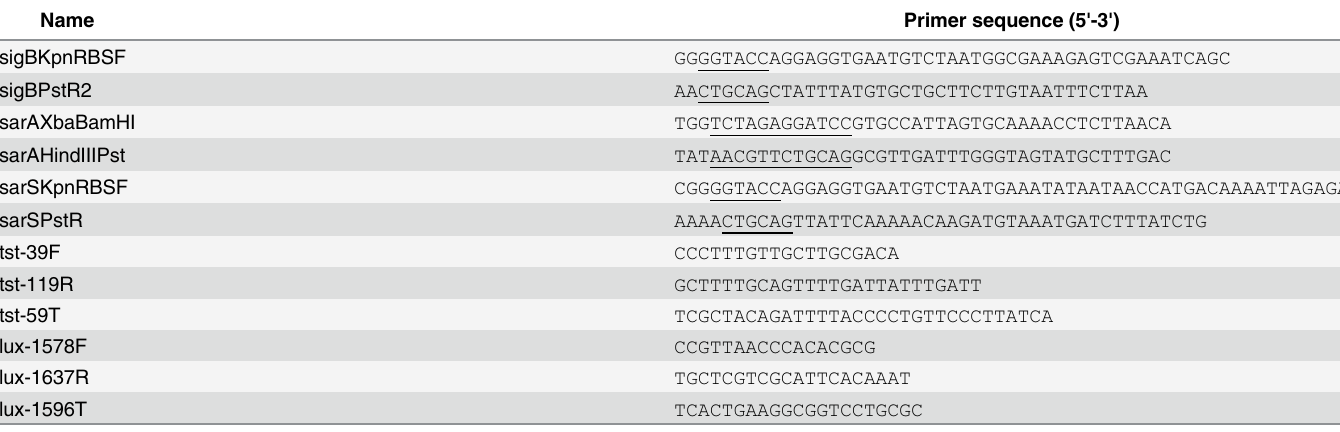
Table 2. Primers and probes used in this